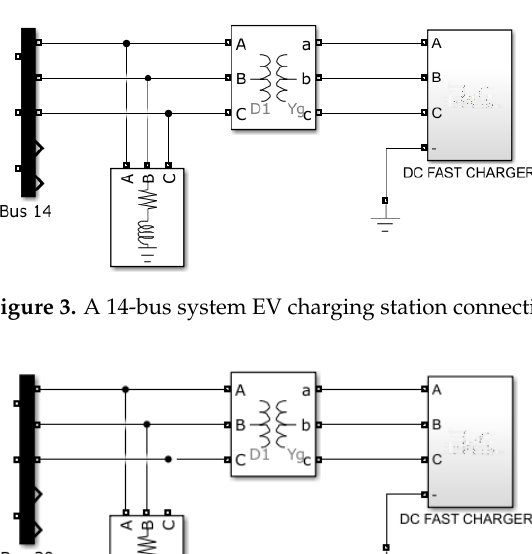
Figure 2. A 6- bus system EV charg ing station connection.